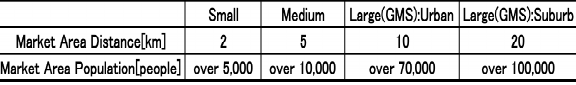
Figure 2. Rates of supermarkets that satisfy the survival conditions in